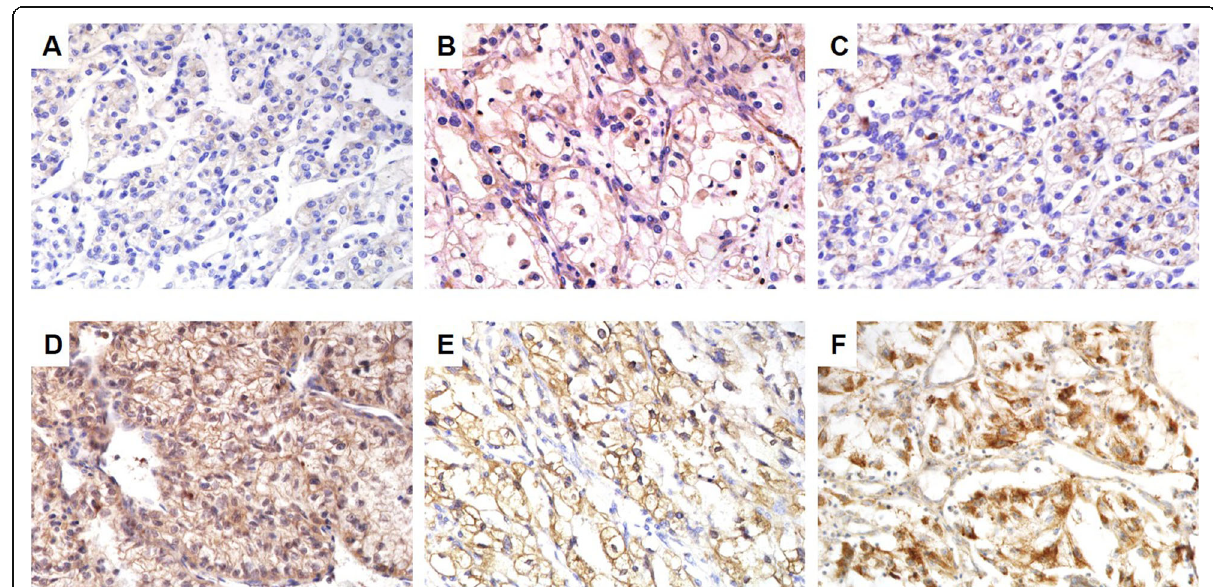
Fig. 1 The expression of the RSK4, CD44 and MMP-9 proteins varies in primary ccRCCs and metastatic ccRCCs. a , d ; b , e ; c , f are form the same patients. a - c : primary ccRCCs, d - e : metastatic ccRCCs, × 400. a weak positivity for RSK4 protein. b weak positivity for CD44 protein. c weak positivity for MMP-9 protein. d positivity for RSK4 protein. e positivity for CD44 protein. f positivity for MMP-9